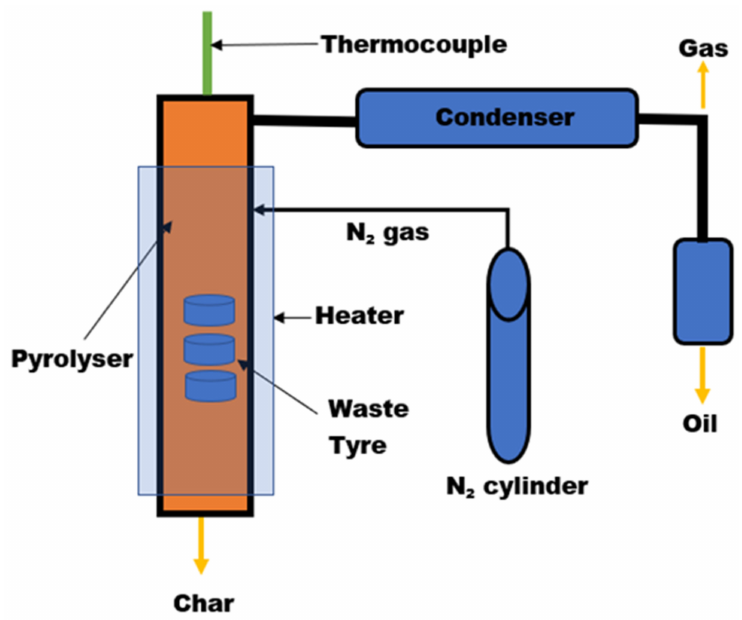
Figure 4. Diagram of a fixed bed pyrolysis